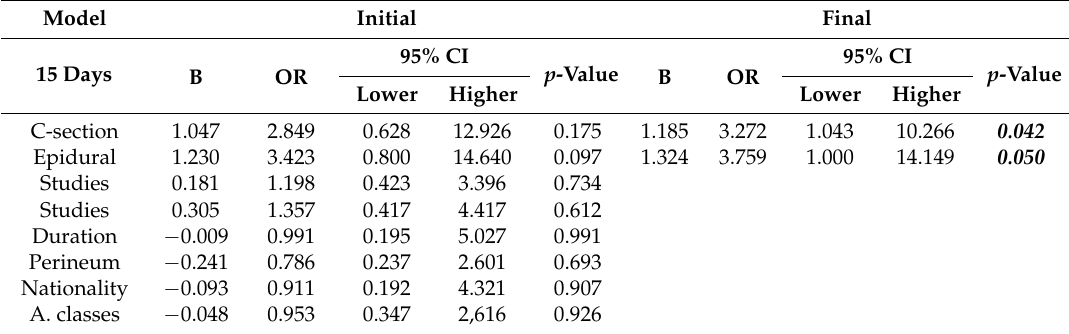
Table 4. Binary regression logistic model, predictors of childbirth experience at 15 days after birth ( n = 90).